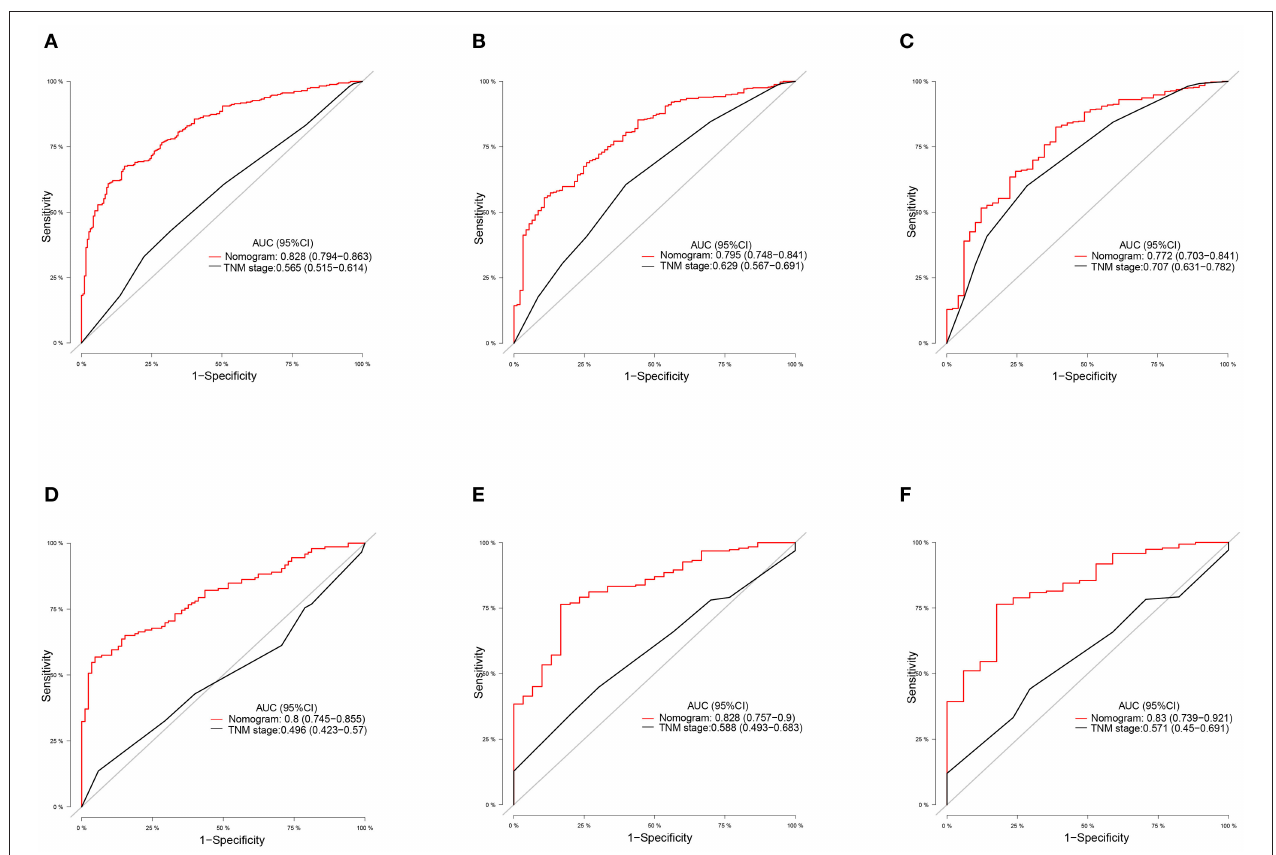
FIGURE 7 | ROC curves of the ability of nomogram and TNM stage to predict 6-, 12- and 18-months overall survival in (A–C) training cohort and (D–F) validation